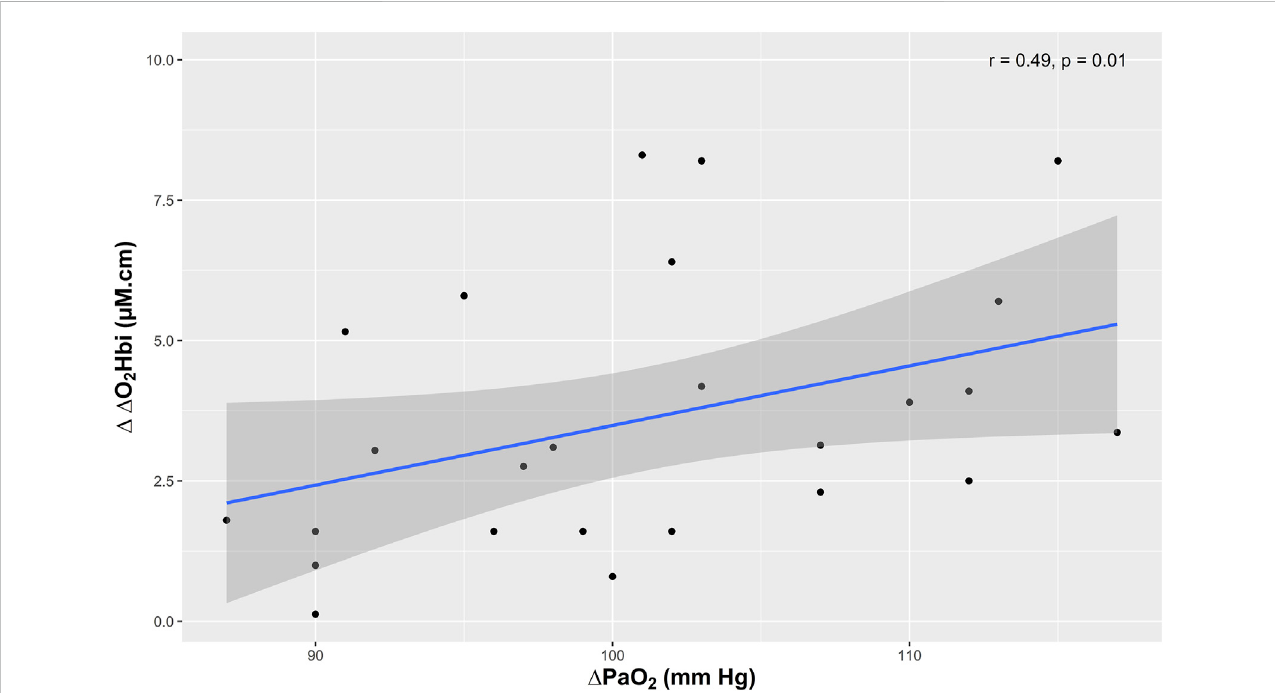
FIGURE 3 Scatter plots showing the correlation (r) between changes in the arterial component of cerebral oxygenation ( Δ O 2 Hbi) and partial pressure of oxygen (PaO 2